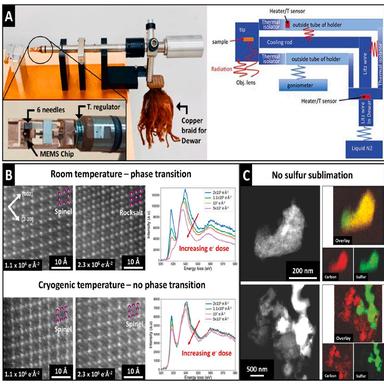
(A) Photographs of a LN2 double-tilt specimen holder (left) and a schematic illustration with a labeling of the different parts (right); adapted with permission from Ref., Copyright 2021 American Chemical Society, and, Copyright 2016 John Wiley & Sons. (B) Atomic-resolution high-angle annular dark-field STEM (HAADF-STEM) images and a series of electron energy loss spectroscopy (EELS) datasets obtained from LiNi0.5Mn1.5O4 analyzed at room temperature (top) and cryogenic temperature